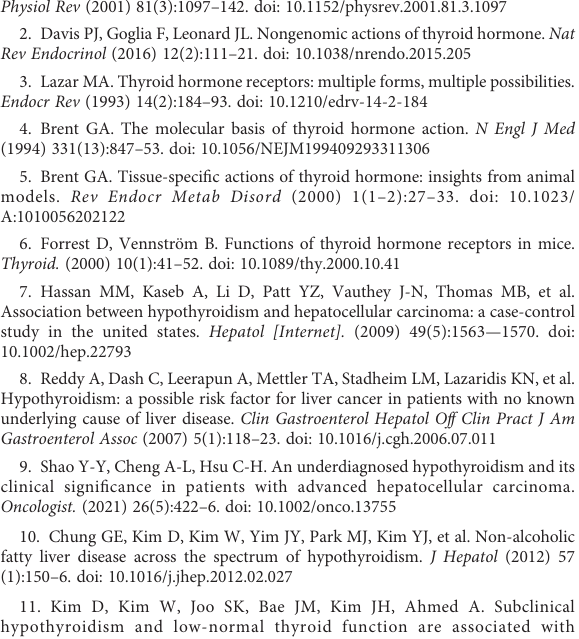
SUPPLEMENTARY FIGURE 3 qRT-PCR analysis of miR-185-5p miR-182 and miR-224 in GSTP- positive preneoplastic nodules in rat livers subjected to the R-H protocol and then treatedwithT3ornotfor4days.U6snRNAwasusedasendogenouscontrol. Relativequanti fi cationanalysisformiR-182wascalculatedby2 - DD Ct method. Student t-test: ** P < 0.01. Values are expressed as mean ±